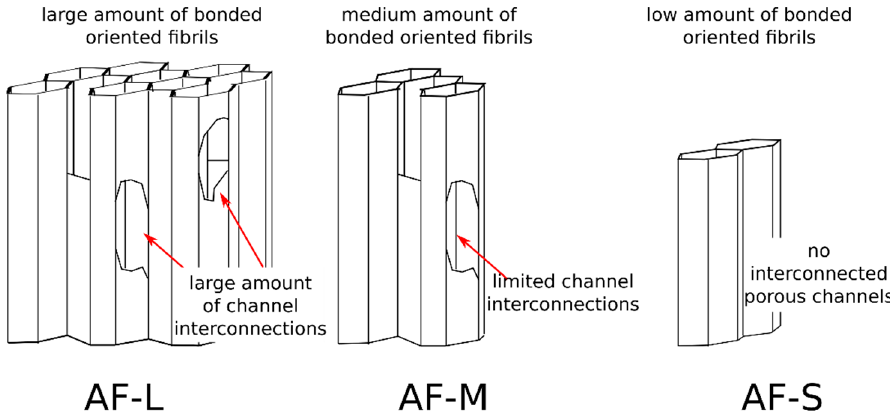
Figure 5. Schematic representation of samples’ morphology.